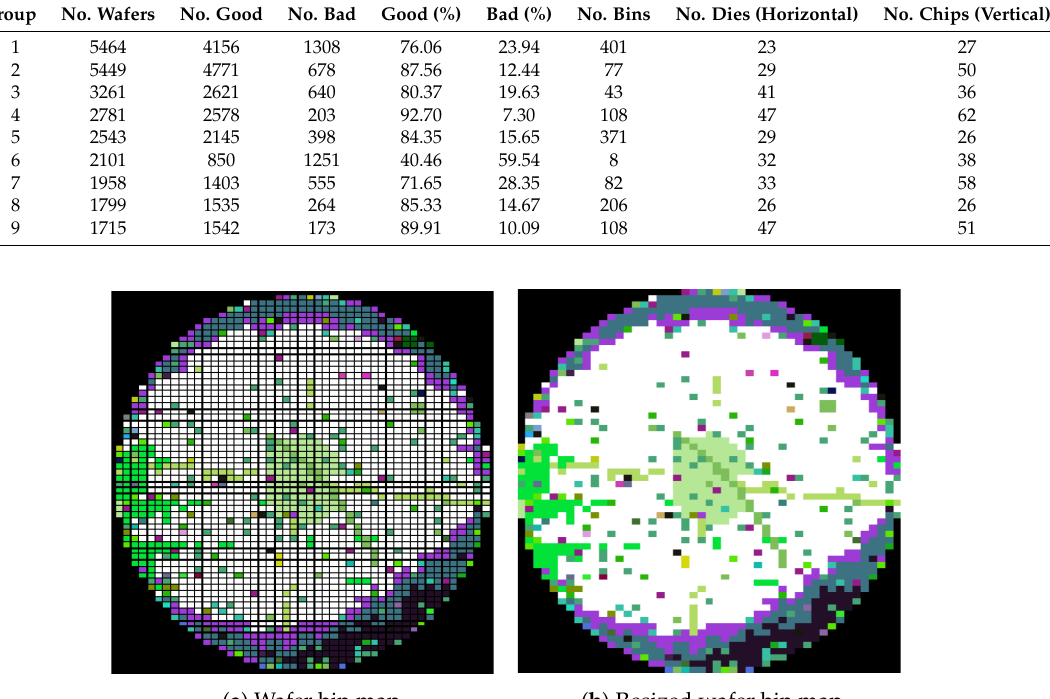
Table 2. Raw data information of WBM.